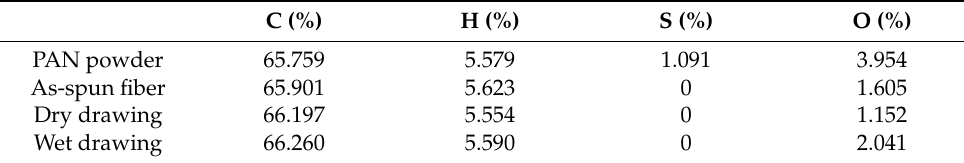
Table 1. Element analysis results of each